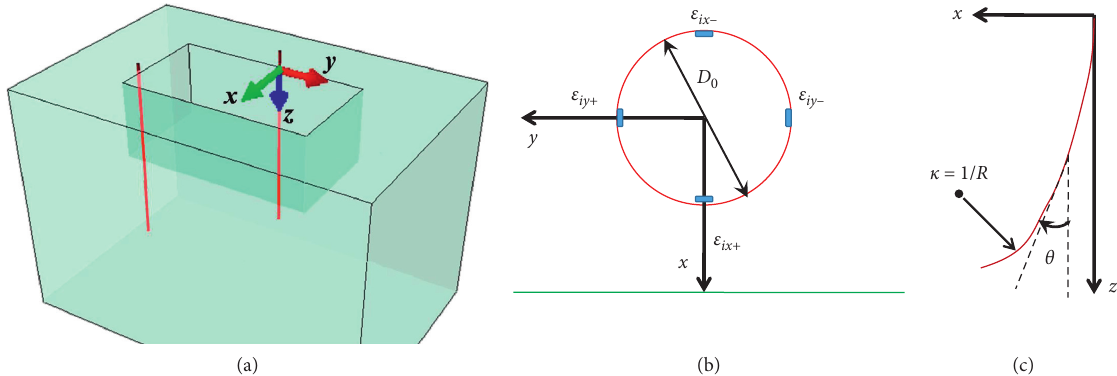
Figure 5: Coordinate system in the theoretical analysis.